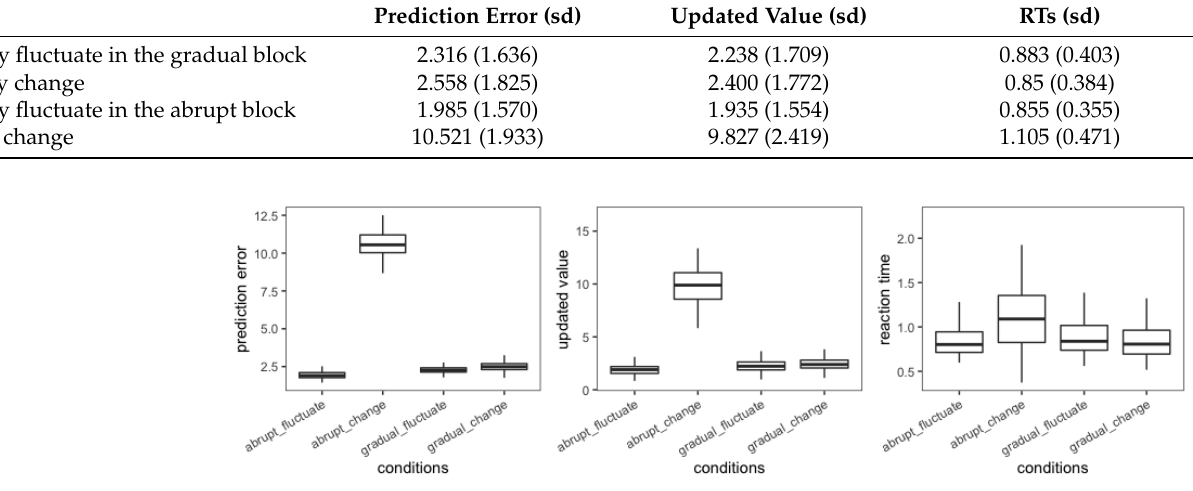
Table 3. The learning rate in the gradually changed block and the abruptly changed block: Results of mixed-linear model.